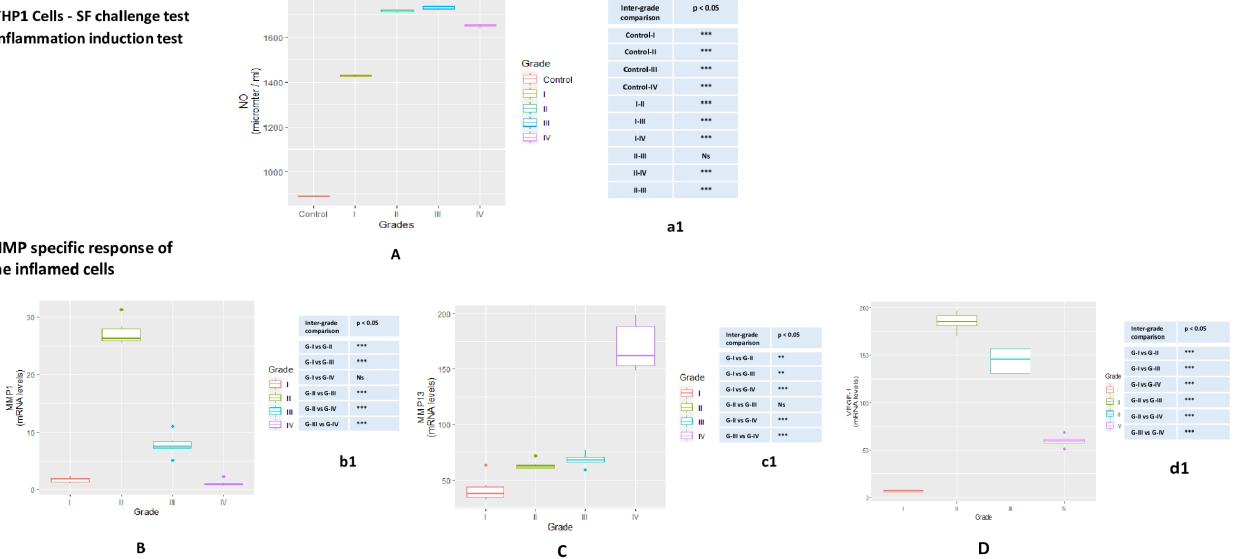
Figure 4. SF challenge test on THP1 cells—the test was carried out to assess MMPs modulation in inflamed THP1. These cells were treated with 10% SFs (of culture media) of progressive OA grades for 48 hrs in order to induce inflammation. Inflammation induction test—( A ) NO release after 48 hrs of SF treatment on THP1 cells; NO significance, revealed during inter-grade comparison is showed in table a1. MMP-specific response of the inflamed cells—( B ) MMP-1: the highest rise in the expression in the cells treated with SFs from KL grade-II; ( C ) MMP-13: a grade-wise elevation was seen in MMP-13 expression; the maximum up-regulation was found in the cells treated with SFs from KL grade-IV; ( D ) VEGF: the highest estimation of VEGF was in the cells treated with KL grade-II SFs that was followed by a grade-wise decline in the expression; the lowest expression was seen in the cells treated with SFs from KL grade-I. Inter-grade difference for MMP-1, MMP-13 and VEGF − 1 on the cells is showed in tables b1, c1 and d1, respectively. * p < 0.05, ** p < 0.01, *** p <